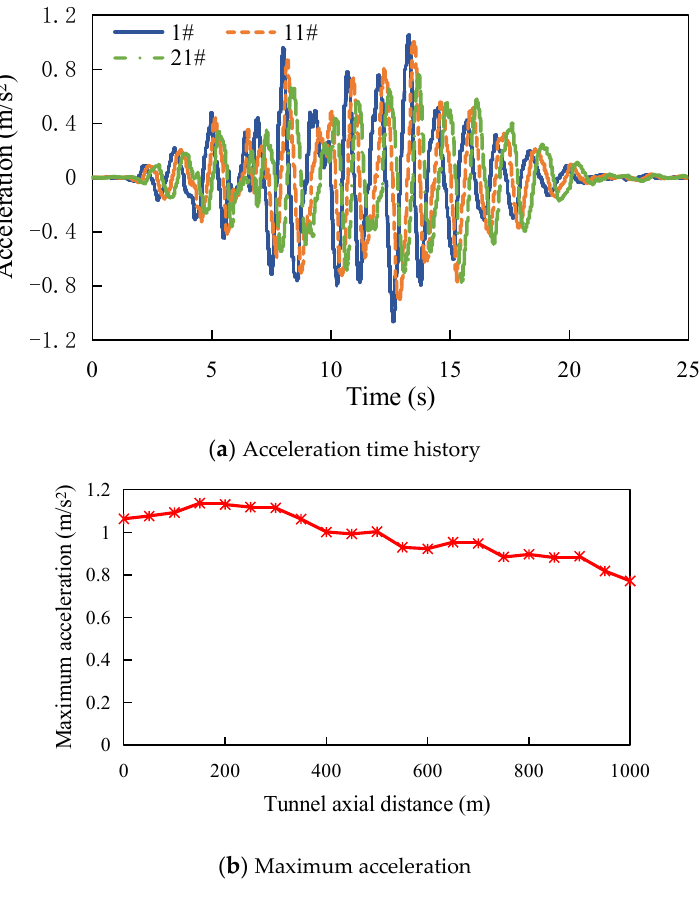
Figure 3. Acceleration–time history curves of non-uniform seismic load.